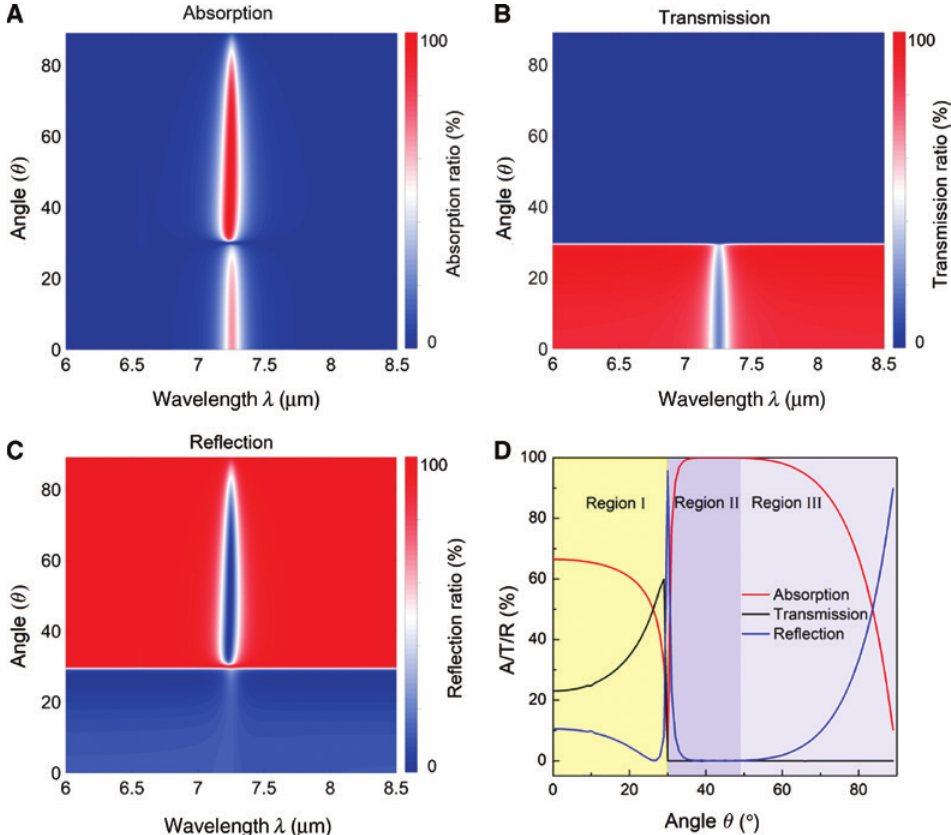
Figure 2: Graphene plasmonic absorptions versus the incident angle. Absorption (A), transmission (B), and reflection (C) mapping as a function of the incident angle and wavelength when n Extracted resonant absorption, transmission, and reflection with varying incident